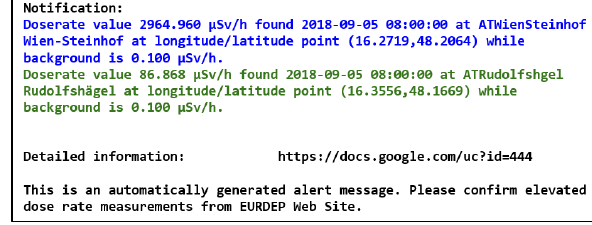
Figure 18. Example of the EURDEP-derived alert